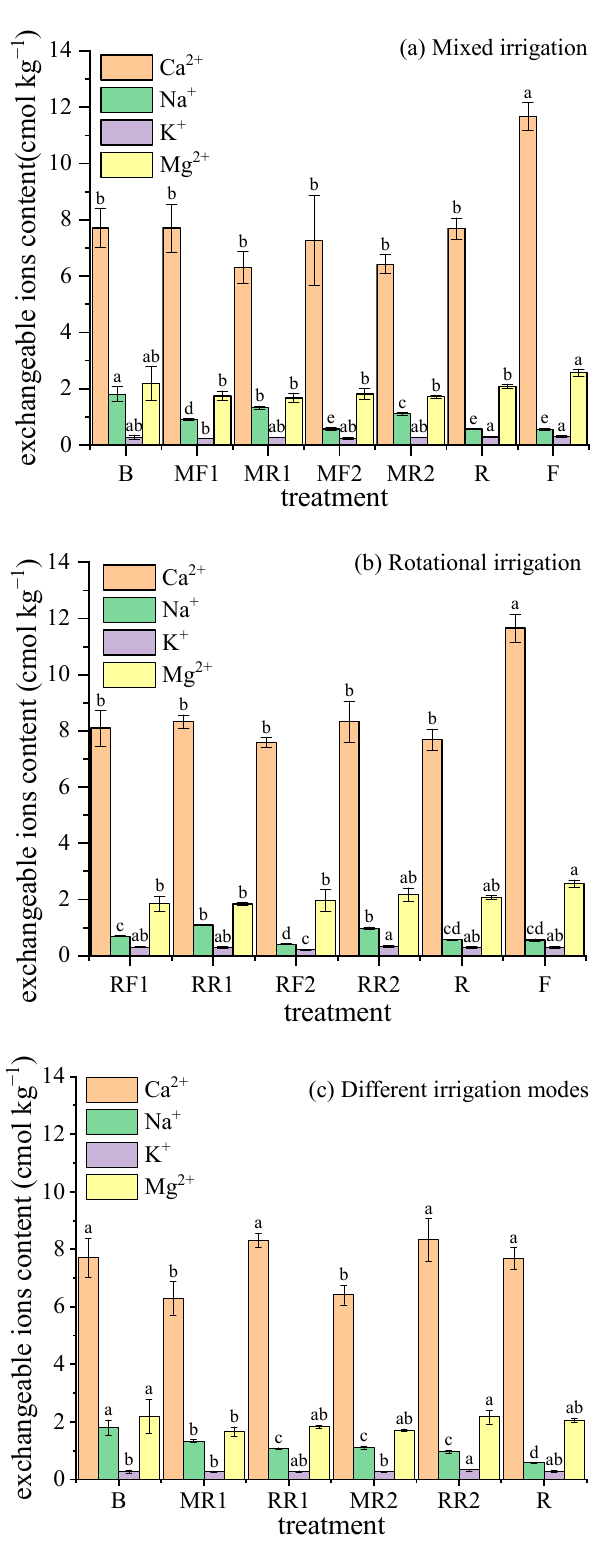
Figure 2. Variations in exchangeable ions contents of soil under different irrigation scenarios. Note: different lowercase letters on the lines represent the significant differences at the level of 0.05.